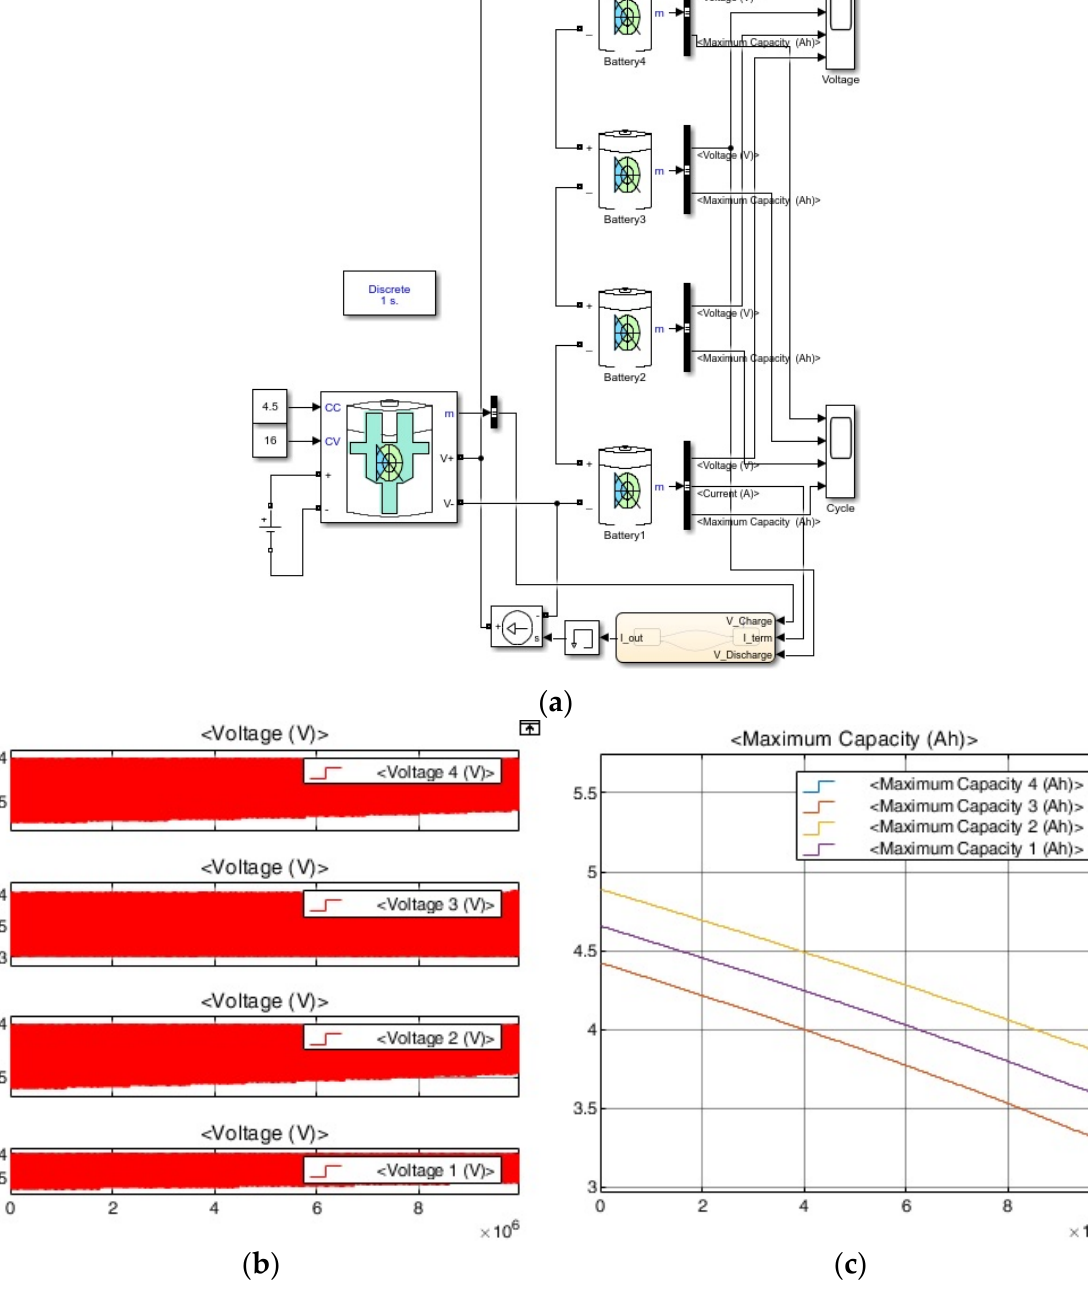
Figure 8. Series connection aging simulation with ±5% capacity deviation. ( a ) Schematic. ( b ) Voltage results. ( c ) SOH results.